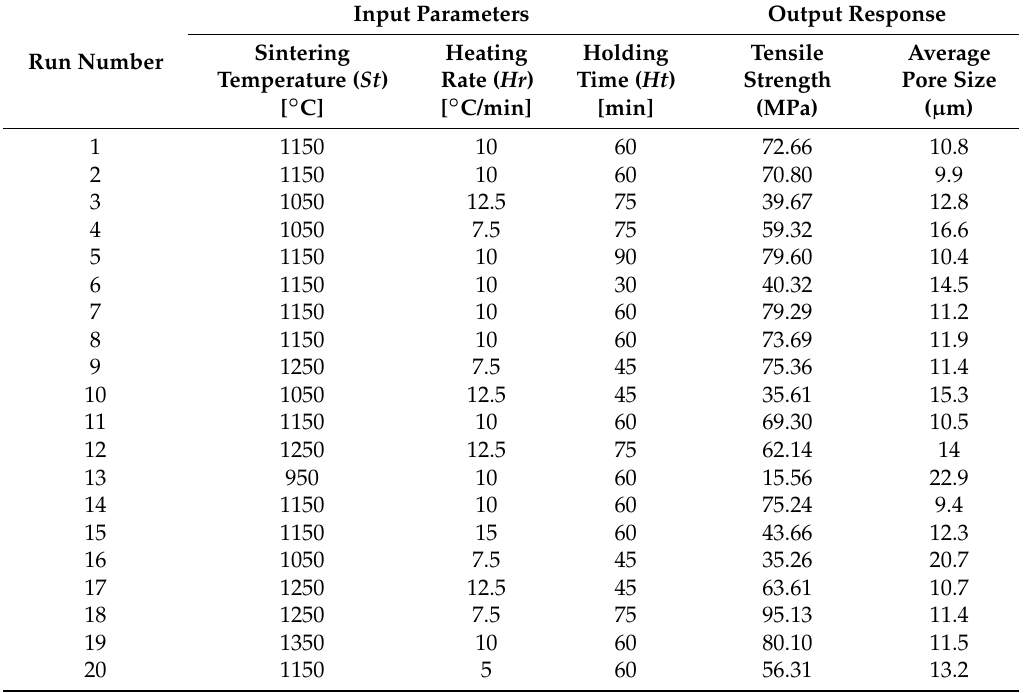
Table 1. Response table for tensile strength and pore size for the 20 CCD-defined experiments.